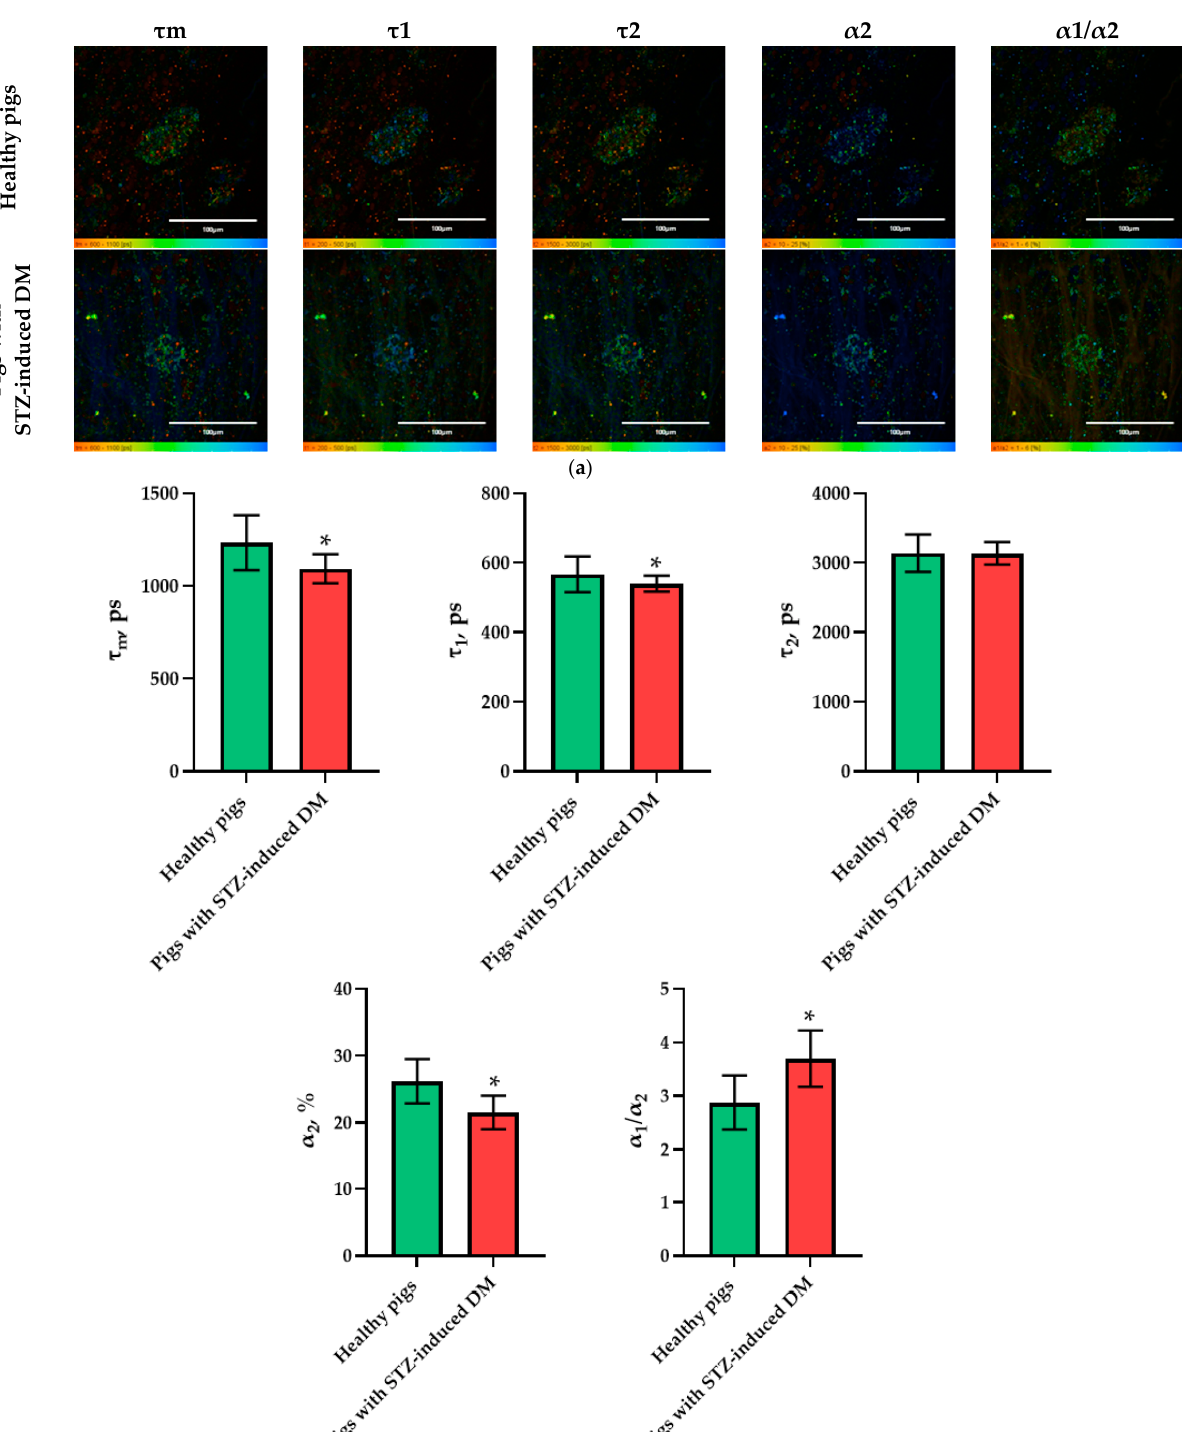
Figure 4. FLIM of NAD(P)H in pancreatic islets of healthy pigs and of pigs with STZ-induced DM. ( a ) Pseudo-color-coded images of τ m, τ 1, τ 2, α 2 and α 1/ α 2 of the NAD(P)H in pancreatic islets of healthy pigs and in pigs with STZ-induced DM (scale bars: 600–1100 ps ( τ m), 200–500 ps ( τ 1), 1500–3000 ps ( τ 2), 10–25% ( α 2) and 1–6 ( α 1/ α 2)). The scale length in all pictures is 100 µm. ( b ) Mean values of τ m, τ 1, τ 2, α 2, α 1/ α 2 of the NAD(P)H in pancreatic islets of healthy pigs and in pigs with STZ-induced DM (mean ± SD). *— p = 0.00000.